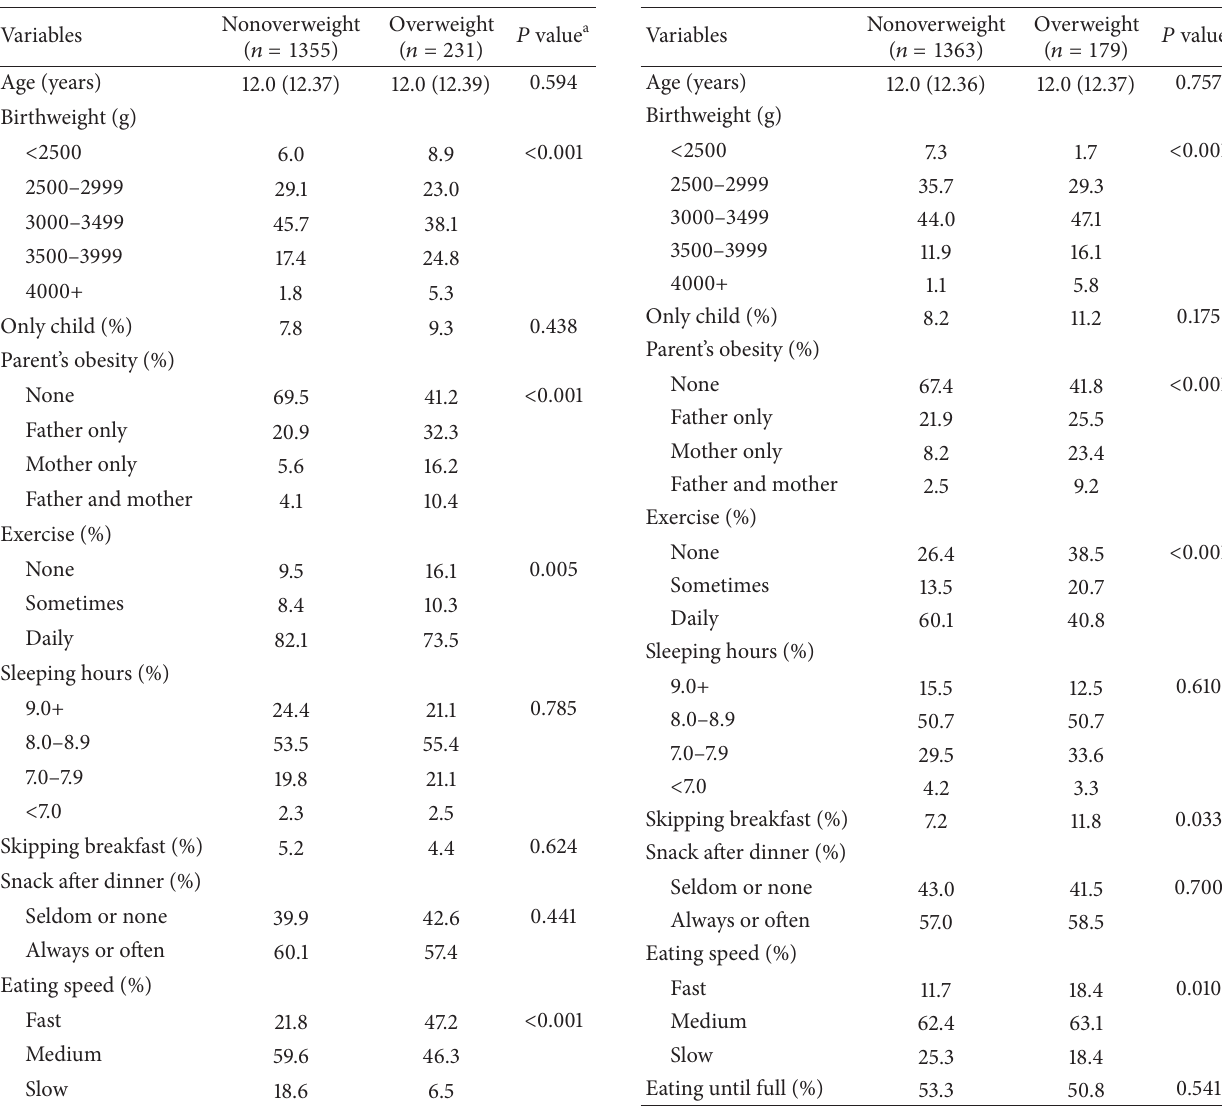
Table 1: Characteristics of the nonoverweight and the overweight boys among study participants.